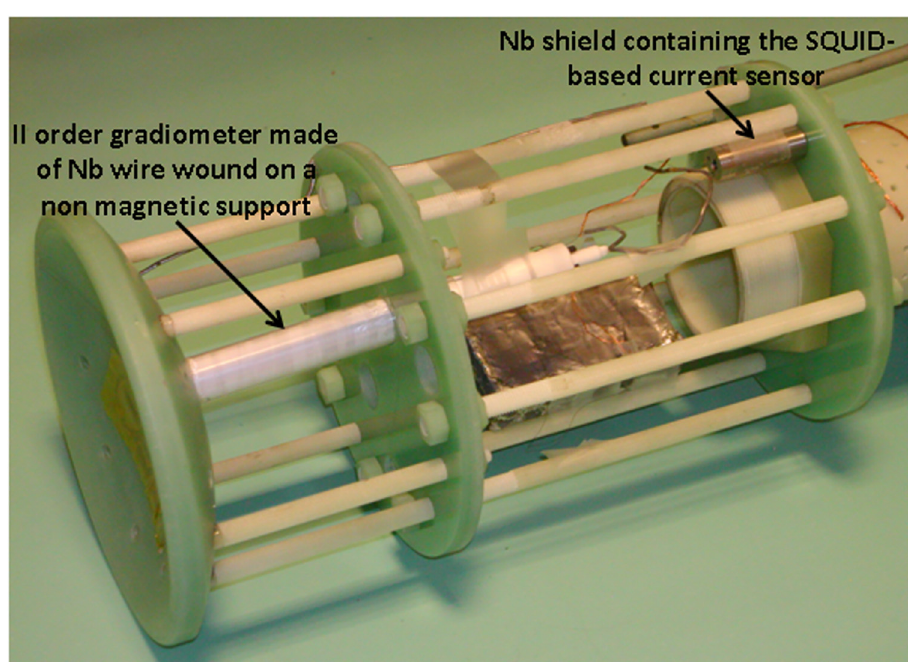
Fig 2. MEG channel consisting of a superconducting II order gradiometer coupled to a dc SQUID. Both the superconducting connections and the SQUID are placed inside superconducting shields. The MEG channel is mounted on the same probe supporting the superconducting detector described in